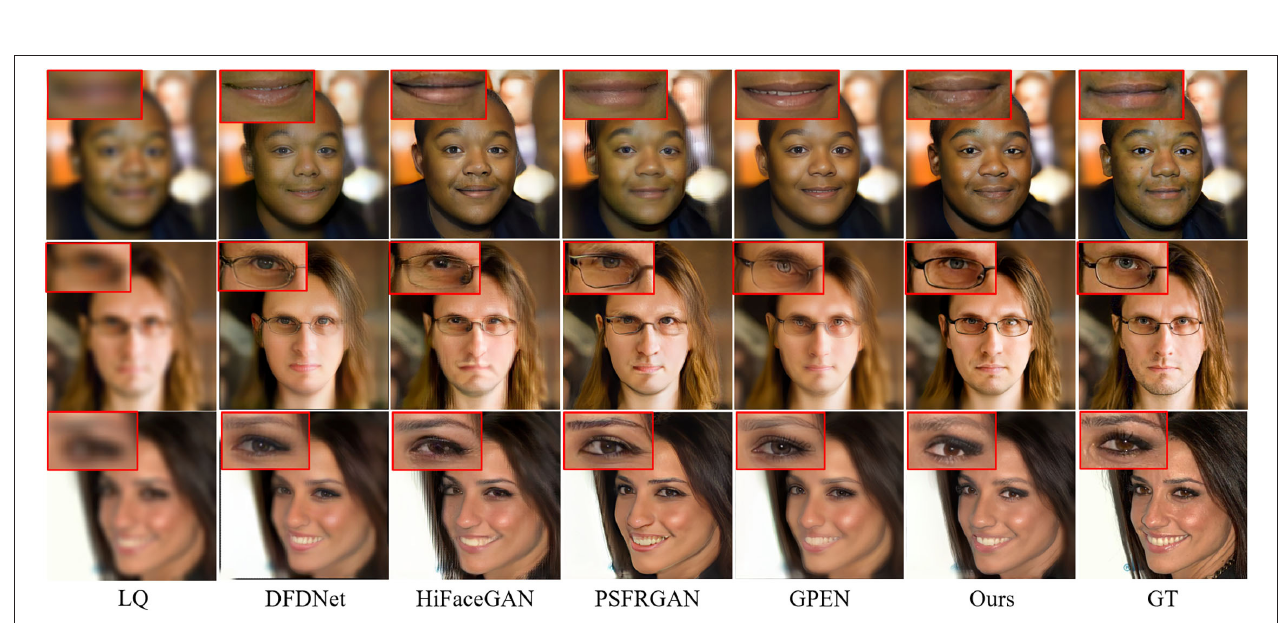
7.15 SR, kernel width × =